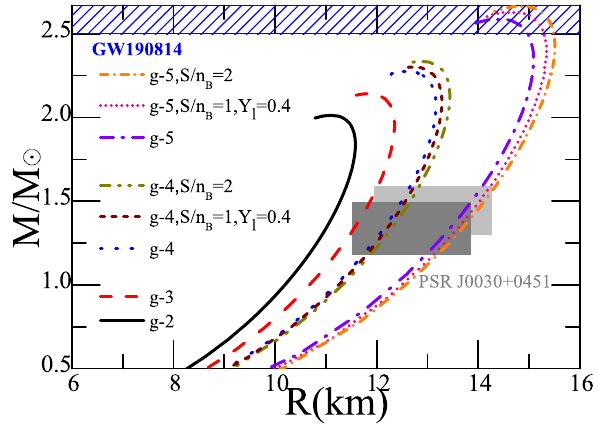
Fig. 5 Mass-radius relation with g-2, g-3, g-4, and g-5 at zero temper- ature and the three snapshots along the PQS evolution for g-4 and g-5 are also